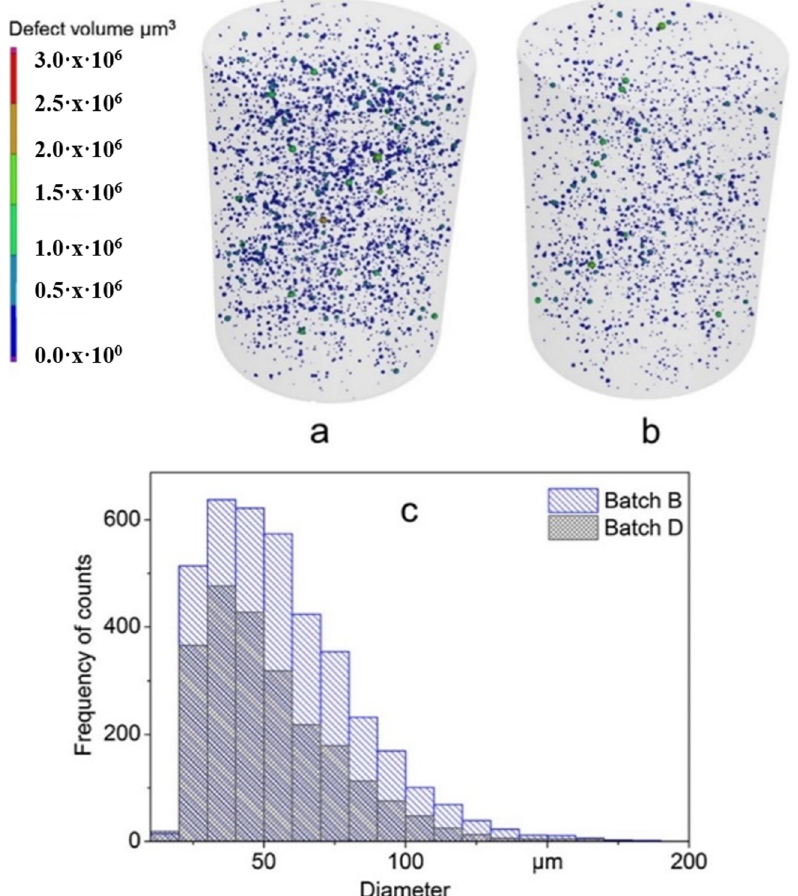
Figure 70. Micro-computed tomography images of Al-12Si alloy with two different batches. ( a ) batch B: 0.25% porosity ( b ) batch D: 0.12% porosity and ( c ) histograms showing the distribution of defects in both batches [122]. Copyright 2016. Adapted with permission from Elsevier Science Ltd. under the